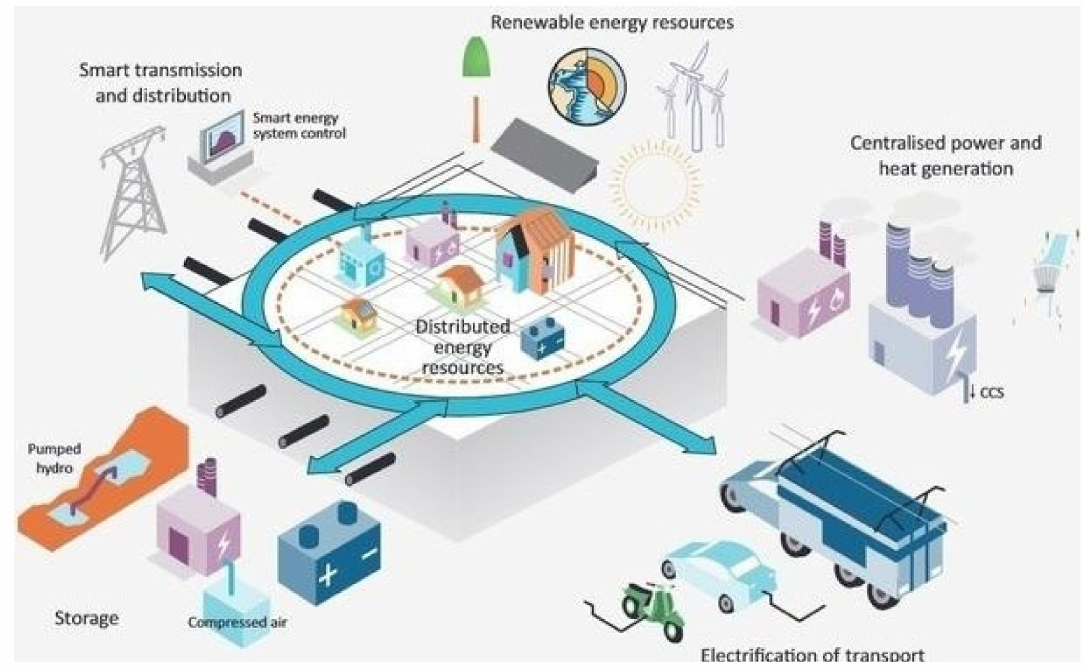
Figure 1. The energy transition as perceived from the University of Groningen Reproduced from University of Groningen